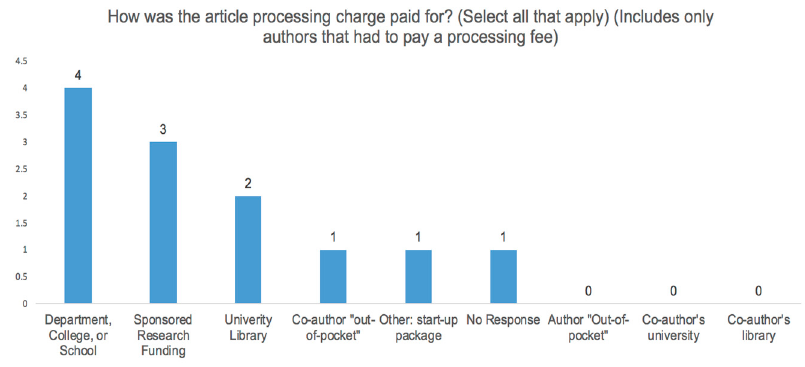
Figure 2. Methods of Payment for APC.